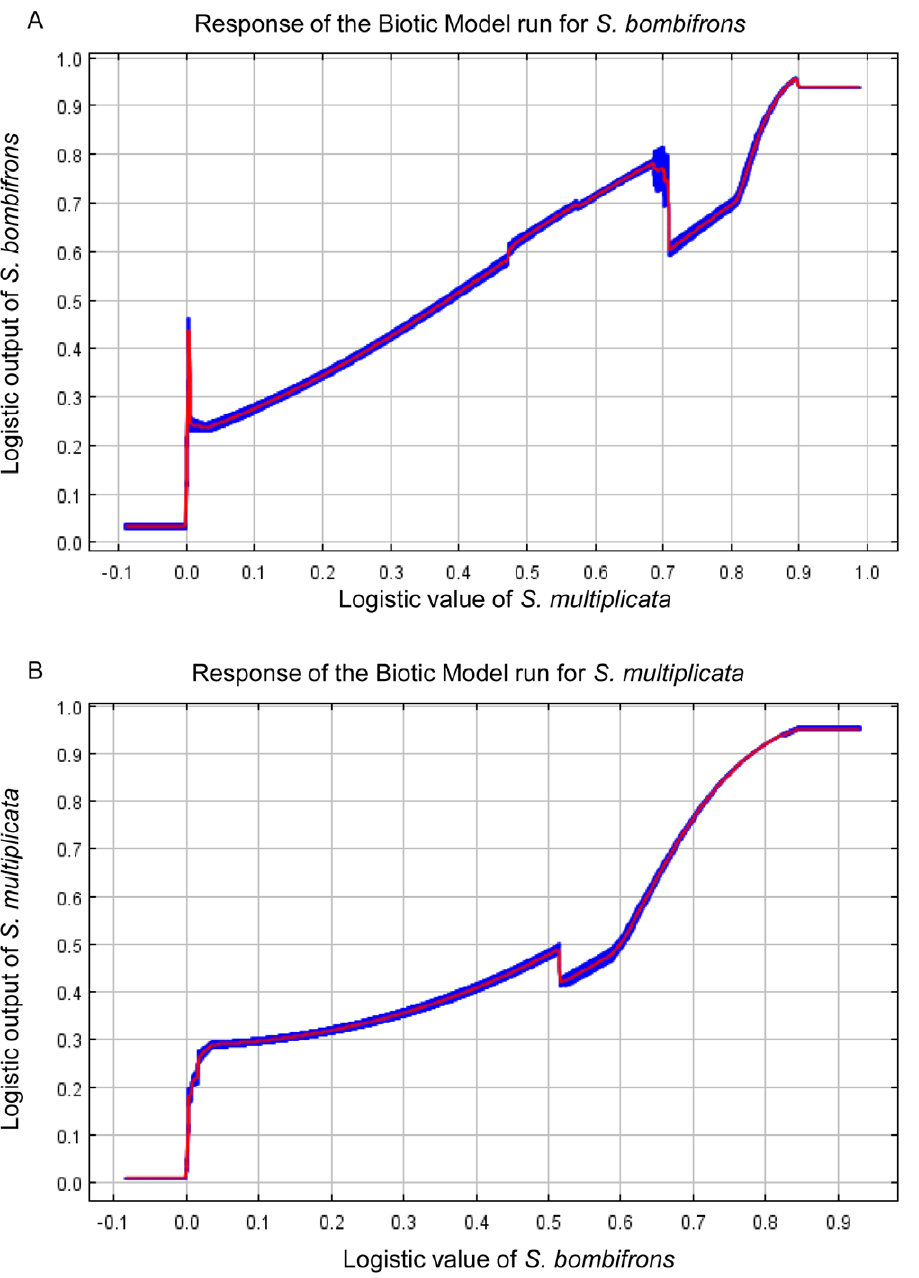
Figure 4. Maxent response curves for the Biotic Model. The response curves of the Biotic Model for (a) S. bombifrons and (b) S. multiplicata . These curves show how the logistic output changes along an ‘environmental gradient’. Here, the environmental gradient is the predicted output of the other species used to create the Biotic Model. The red line shows the average of the 10 replicate runs, while the blue bands shows + / 2 one standard deviation. At low logistic values for one species, the other species has a low logistic value as well. Both species thus show a similar response to the environment (i.e. environments good for one species tend to be good for the other). doi:10.1371/journal.pone.0032748.g004 (mean =20.33 km) for S. bombifrons (t 118 = 3.785, p , 0.001,) and,